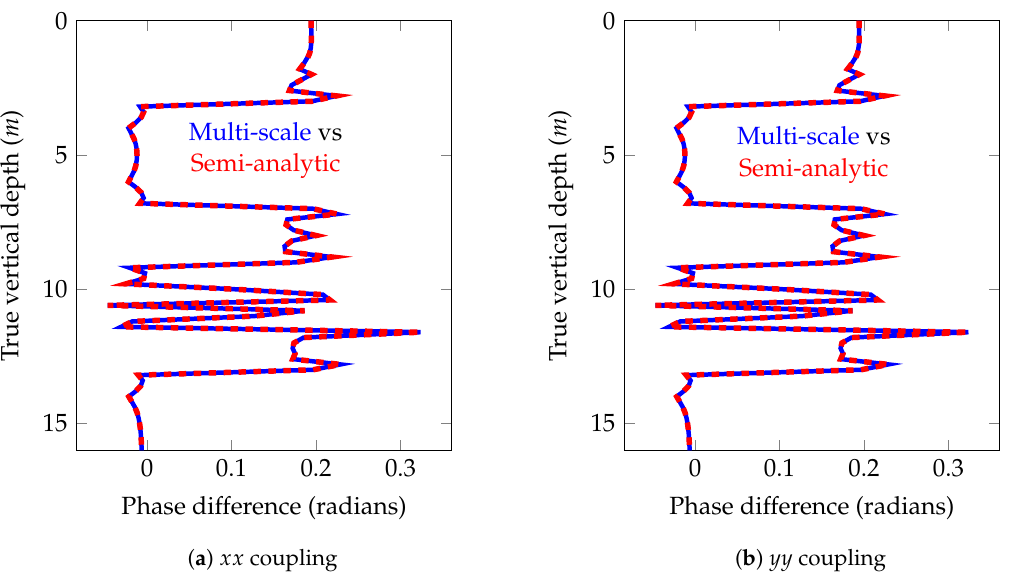
Figure 13. Model problem 2. Phase differences for the non-zero couplings ( xx and yy couplings) of the magnetic field for a vertical well (dip angle = 0 ◦ ).